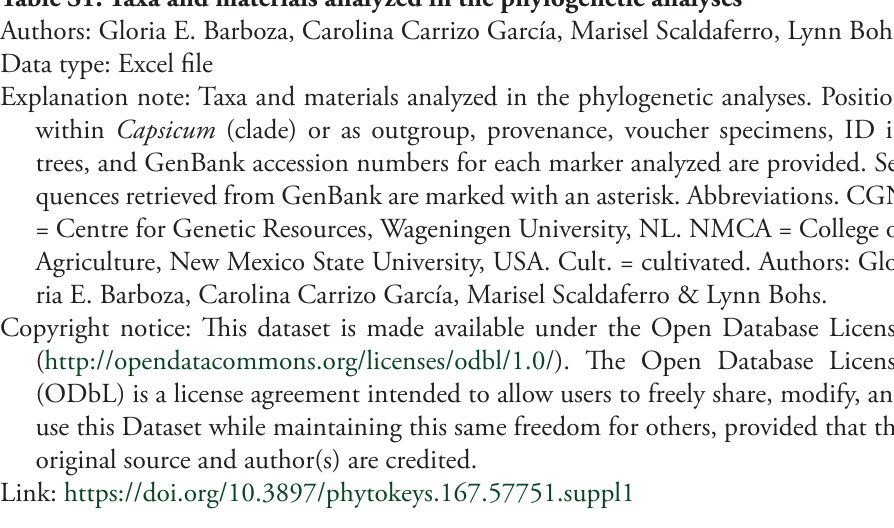
Table S1. Taxa and materials analyzed in the phylogenetic